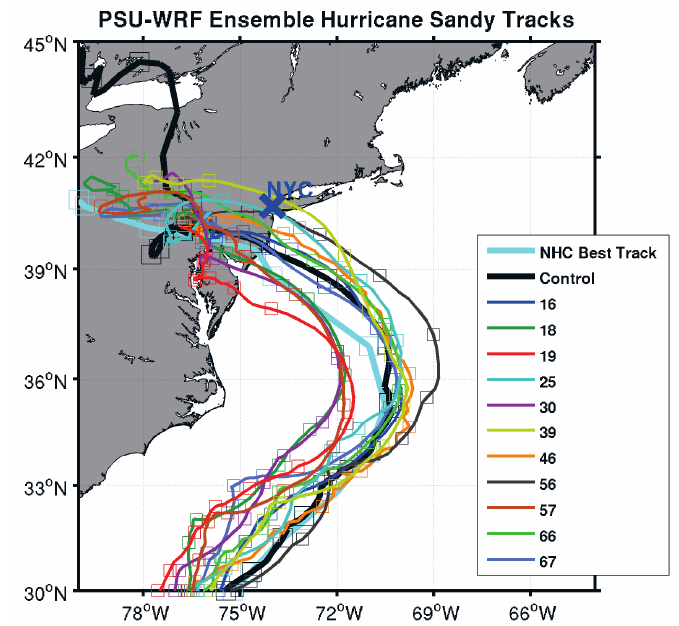
Figure 1. Track of hurricane Sandy for the best track (bold cyan), control WRF member (bold black), and 11 ensemble WRF members (see legend) starting at 00:00 UTC, 26 October 2012 (symbols plotted every 12 h). The location of The Battery tide gauge for the verification is shown at the NYC location (blue